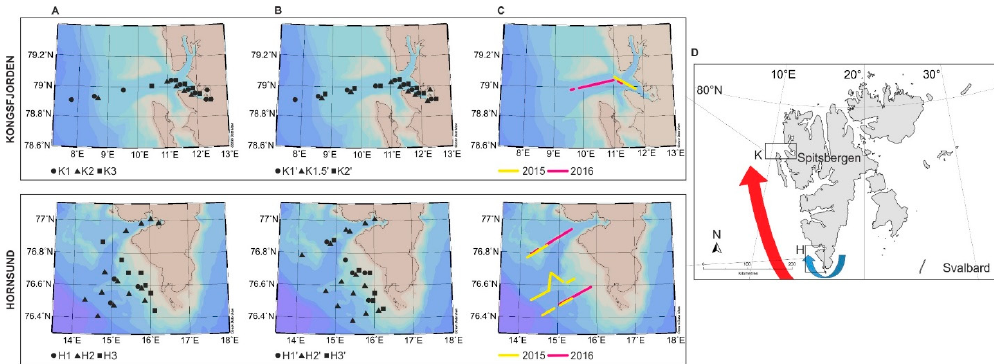
Figure 1. Zooplankton sampling stations in 2015 ( A ) and 2016 ( B ) from two fjords: Kongsfjorden (upper panel) and Hornsund (lower panel) located along the coast of Spitsbergen and sampled during three study periods each year (marked by various shapes of points). The sections of laser optical plankton counter (LOPC) surveys ( C ) are marked with yellow and pink lines. Map of the study area ( D ) with current patterns in the Spitsbergen region (simplified from Sakshaug et al. 2009).